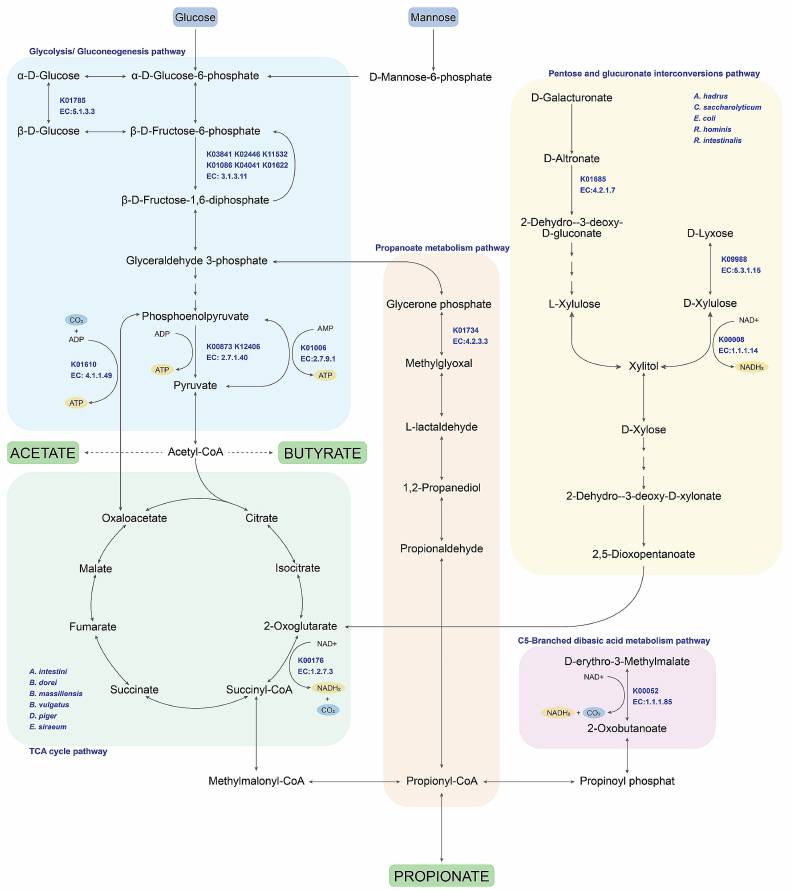
Figure 7. Potential species and related metabolic routes involved in SCFAs biosynthetic pathways. Note: KEGG was used as a pathway